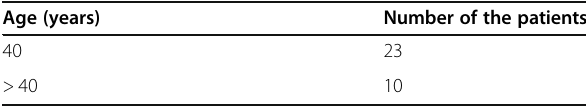
Table 1 Age distribution of 33 patients with GPHC Age